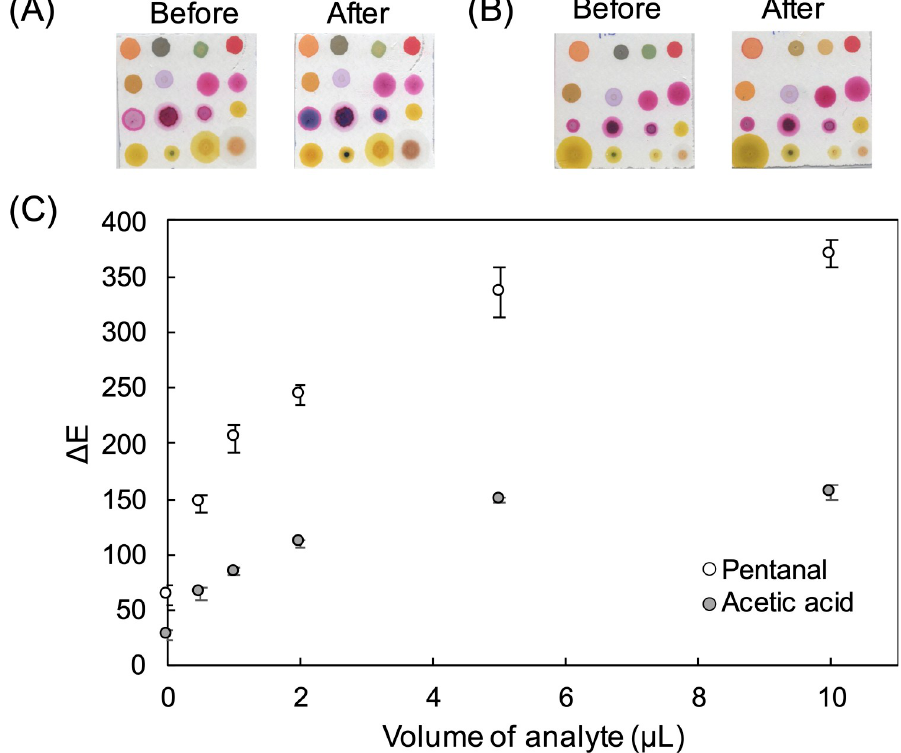
Fig 1. Scanned images of sensor array taken before and after exposure to (A) pentanal vapour and (B) acetic acid vapour; (C) graph shows Δ E (Euclidean distance) for carbonyl sensors to increasing amounts of pentanal and pH sensors to increasing amounts of acetic acid. Error bars represent the standard deviation of